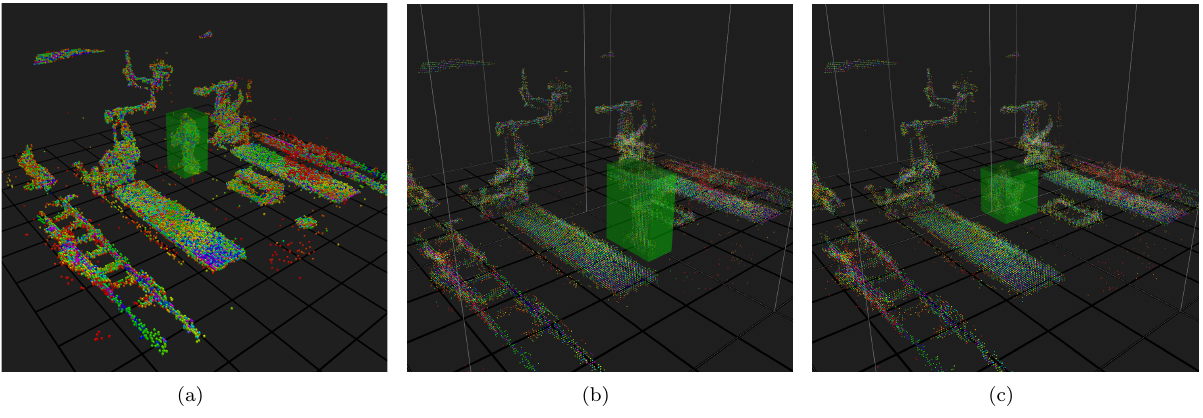
Figure 4: ( a ) Example detection, walking; ( b ) Example detection, arms out; ( c ) Example detection,